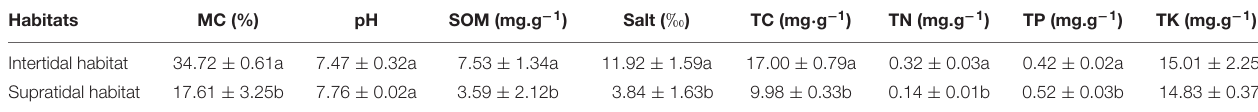
TABLE 2 | Soil physicochemical properties at different habitats. Habitats Intertidal habitat